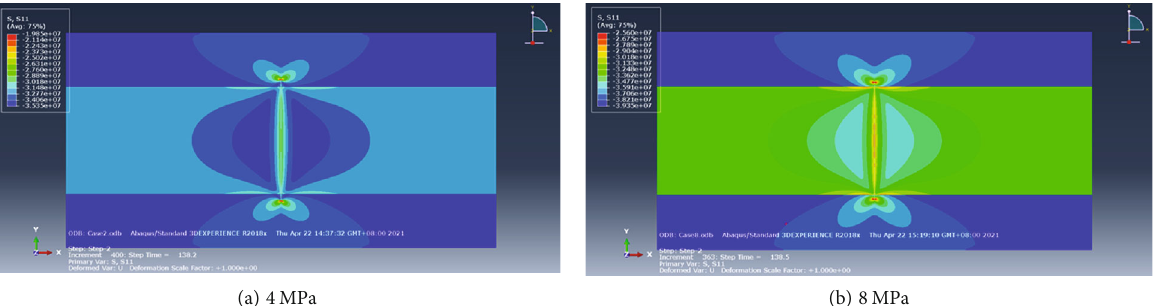
Figure 9: The in fl uence of minimum horizontal stress di ff erence on height growth.